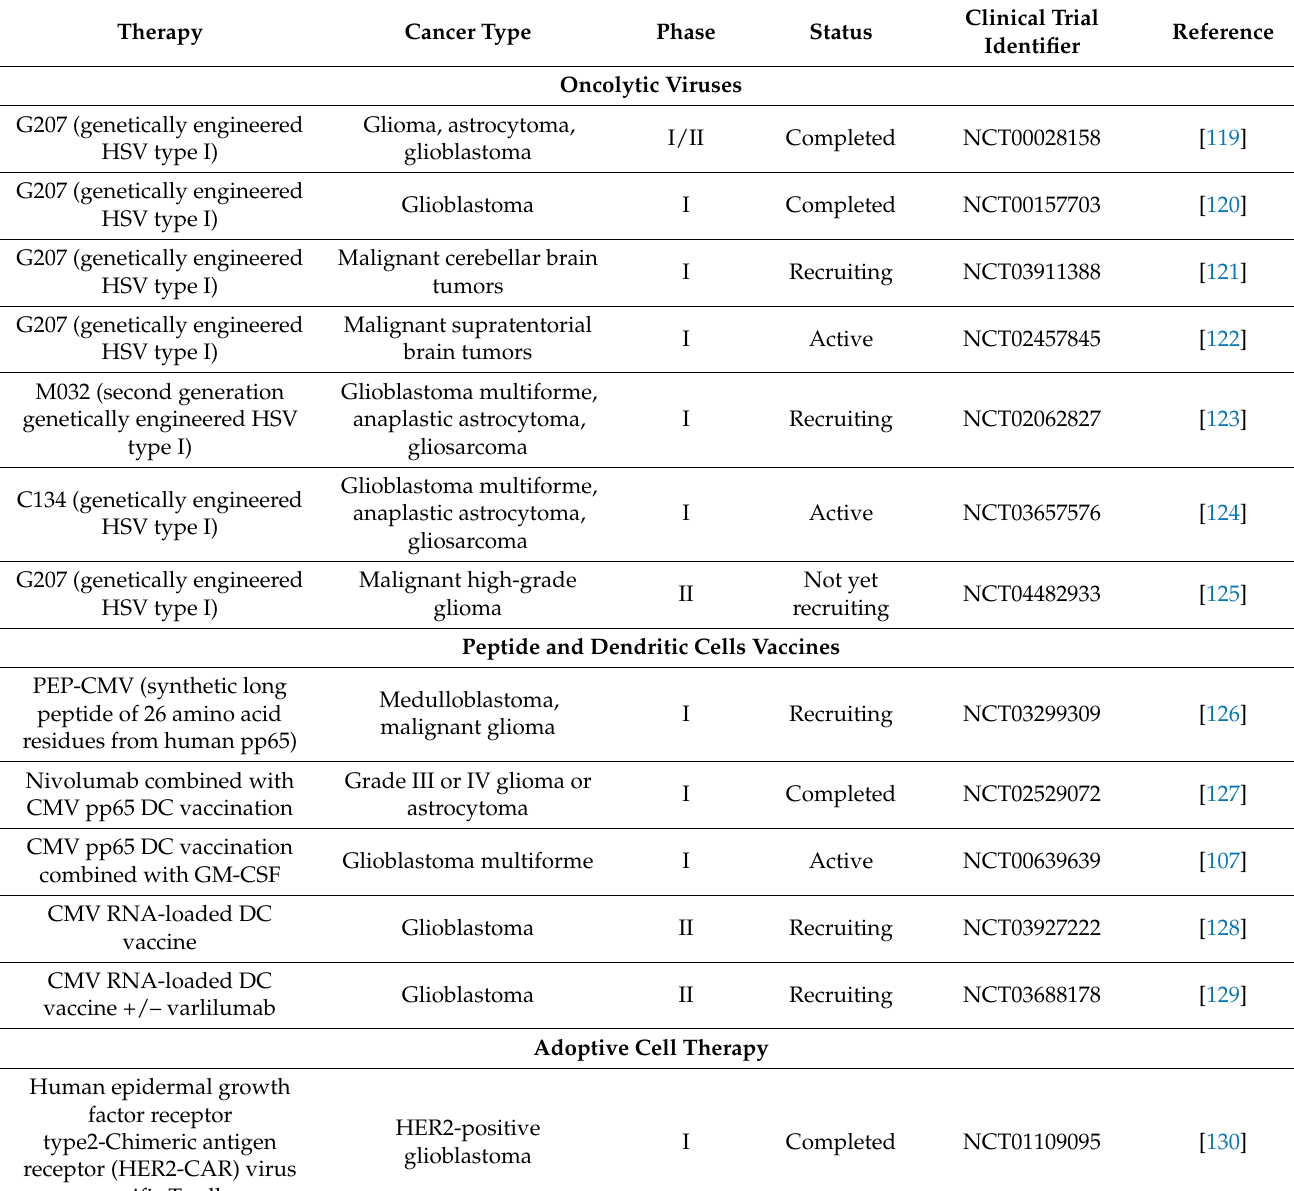
Table 2. Clinical trials in brain tumors that exploit immunotherapeutic strategies and the neurotropism of